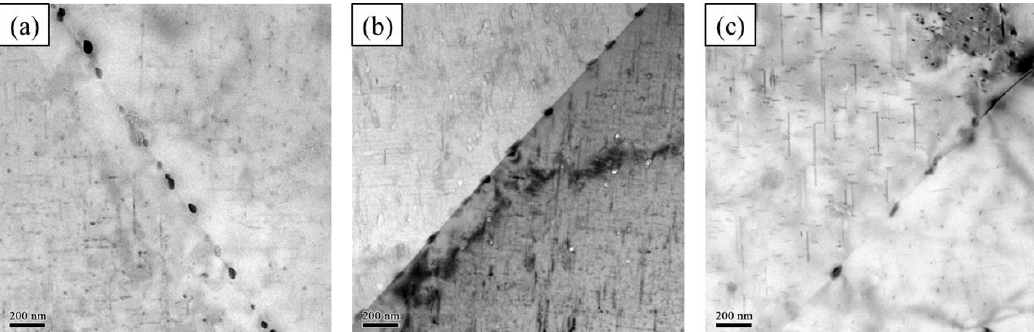
Figure 6. The distribution of ( a ) diameter and ( b ) length of precipitates within grains of the investigated specimens. Table 5. Average diameter, length and number density of the precipitates within the grains.